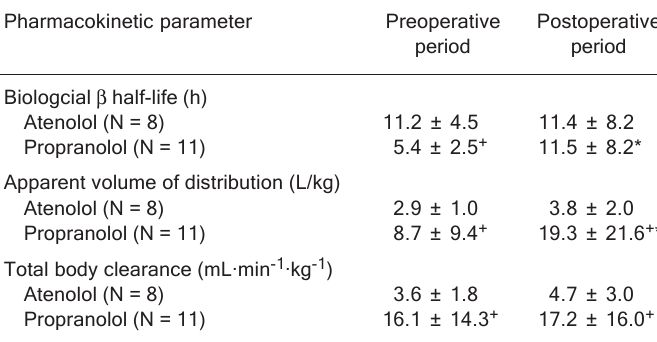
Table 2. Pharmacokinetics of propranolol and atenolol during the pre- and postoperative periods of coronary artery bypass graft surgery with cardio- pulmonary